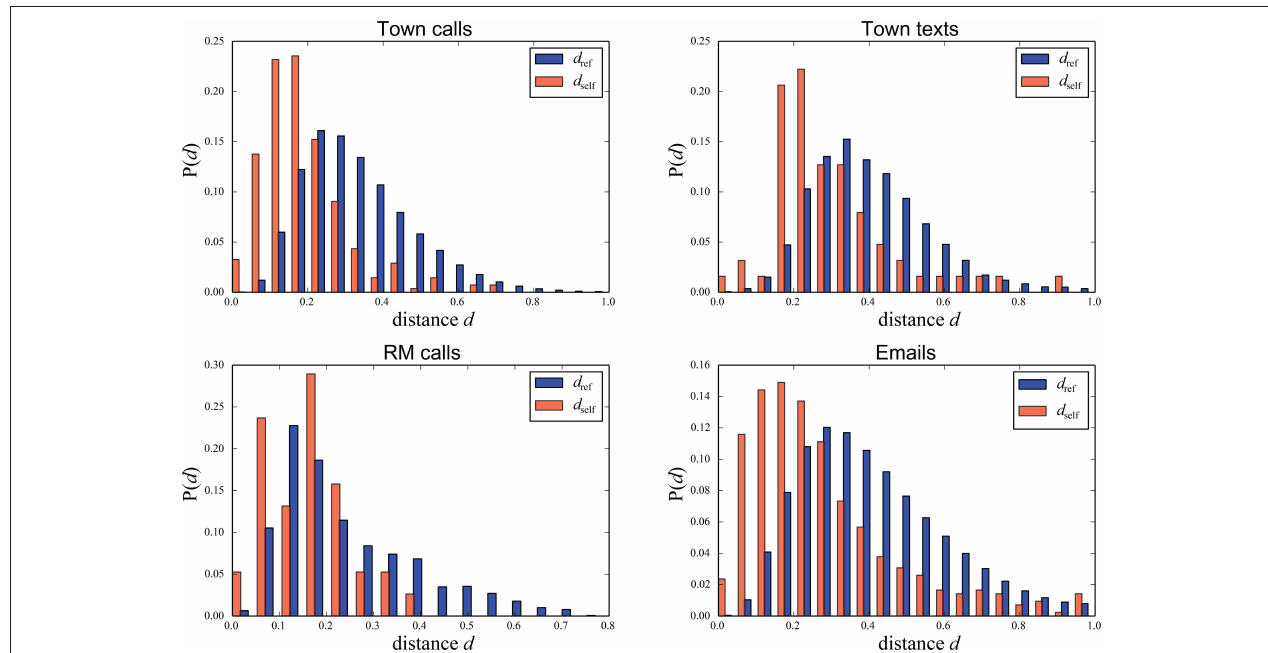
FIGURE 4 | Self and reference distances for daily patterns in our datasets. Self-distance measures the distance between one individual’s daily patterns in two consecutive 4-week intervals, whereas reference distances are computed between all pairs of individuals in a 4-week